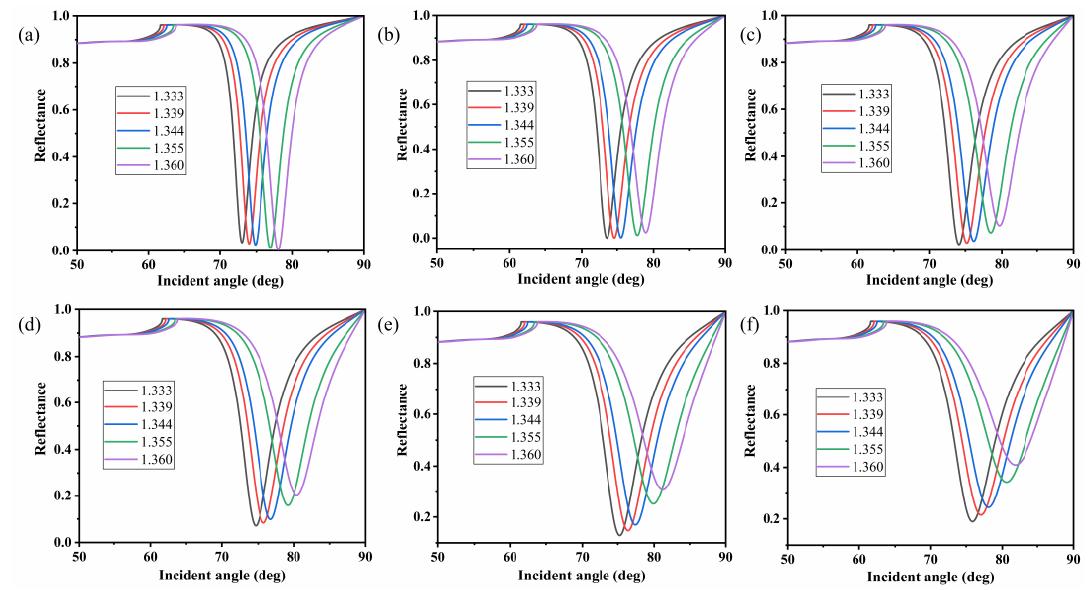
Figure 8. Reflectance curves of the proposed sensor corresponding to different graphene layers: ( a ) without graphene; ( b ) monolayer; ( c ) bilayer; ( d ) three layers; ( e ) four layers; ( f ) five layers. The refractive index of the ethylene solutions changed from 1.333 to 1.360.